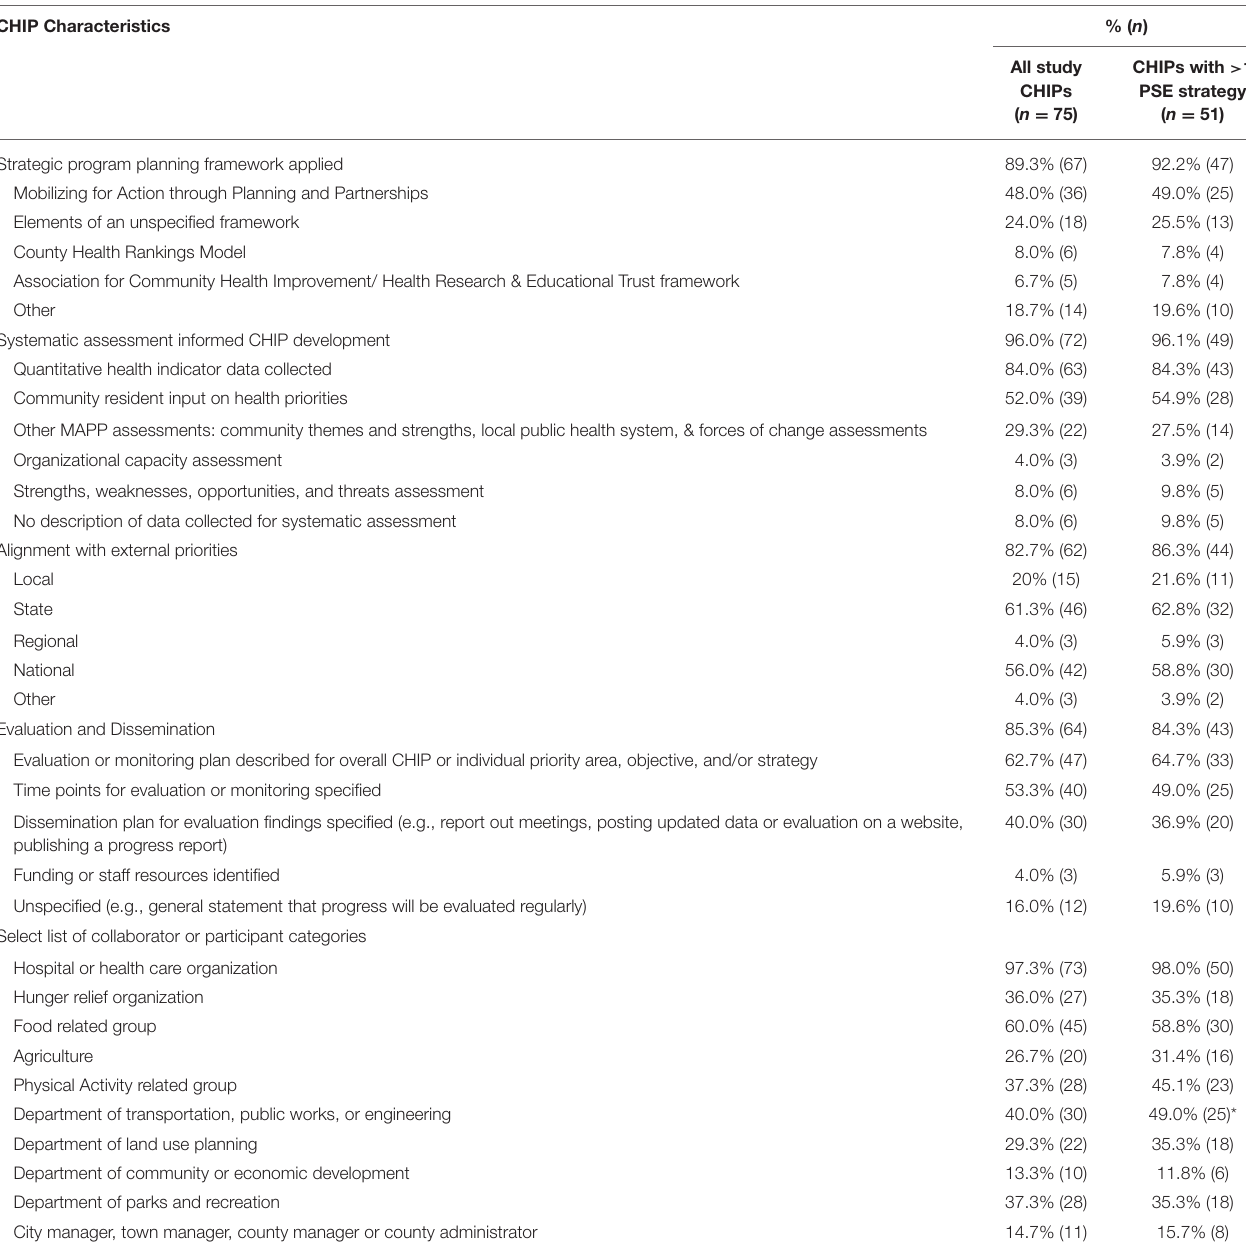
TABLE 1 | Characteristics of CHIP documents among all study CHIPs ( n = 75) and CHIPs with at least one policy, systems, or environmental healthy eating or physical activity strategy ( n = 51). CHIP